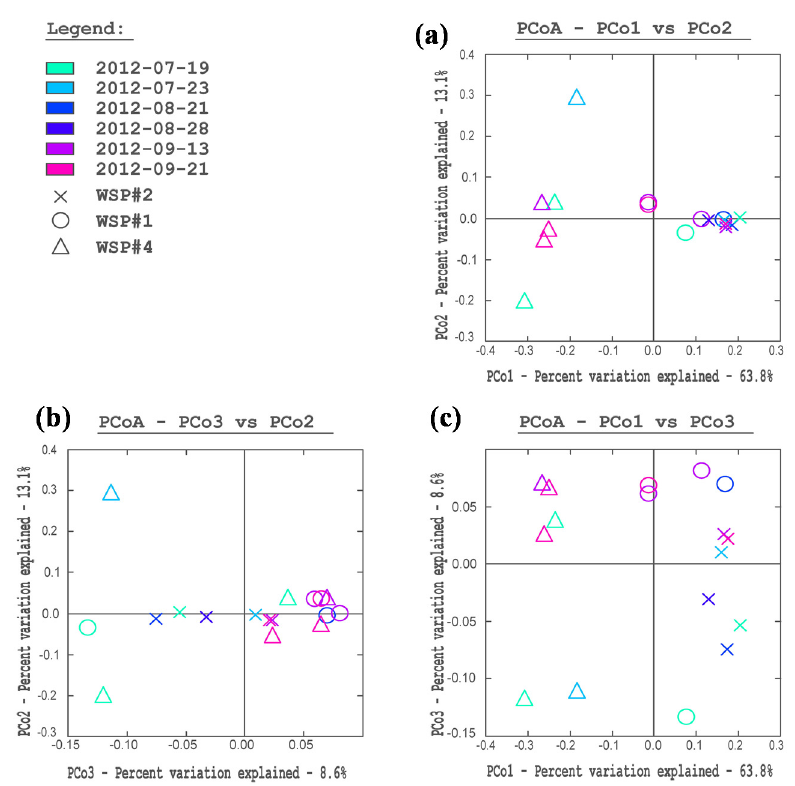
Figure 4. PCoA plots of the samples for the first three principal coordinates of the PCoA analysis, with colour indicating sample data and shape indicating sample location; ( a ) PCo1 vs. PCo2 plot; ( b ) PCo3 vs. PCo2 plot; ( c ) PCo1 vs. PCo3 plot; three outliers—two from WSP#4 and one from WSP#1—are observed and correspond to samples taken from the